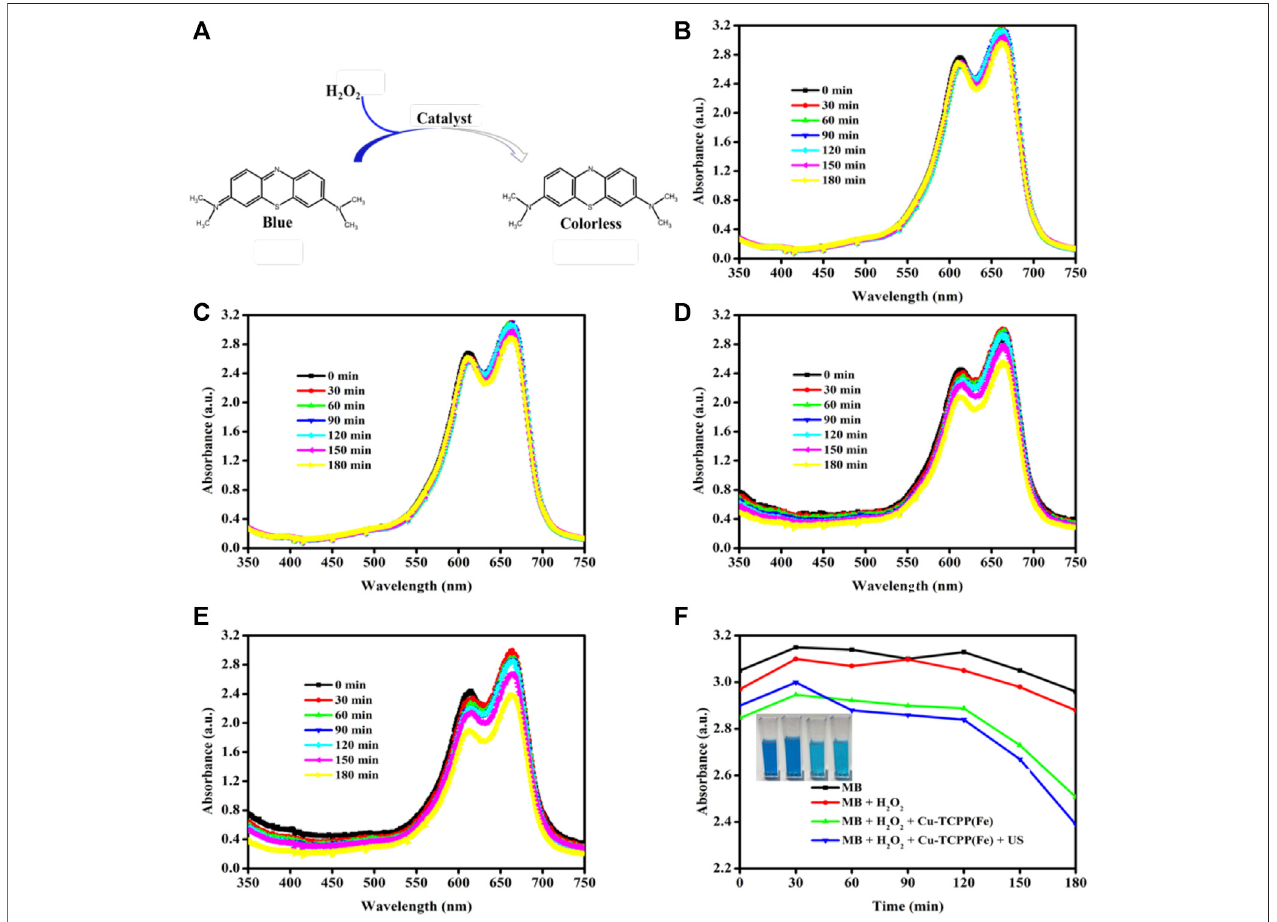
FIGURE4| MB bleachingtest. (A) The sketch map ofMBbleaching. MB absorbance spectrachanges( λ max = 664 nm)at differenttimepoints (0, 30,60, 90, 120, 150, and 180 min)after initiation oftheFenton reaction at (B) pH=6.0, (C) pH =6.0+40 mM H 2 O 2 , (D) pH =6.0+40 mM H 2 O 2 +40 μ g/ml Cu-TCPP(Fe) and (E)